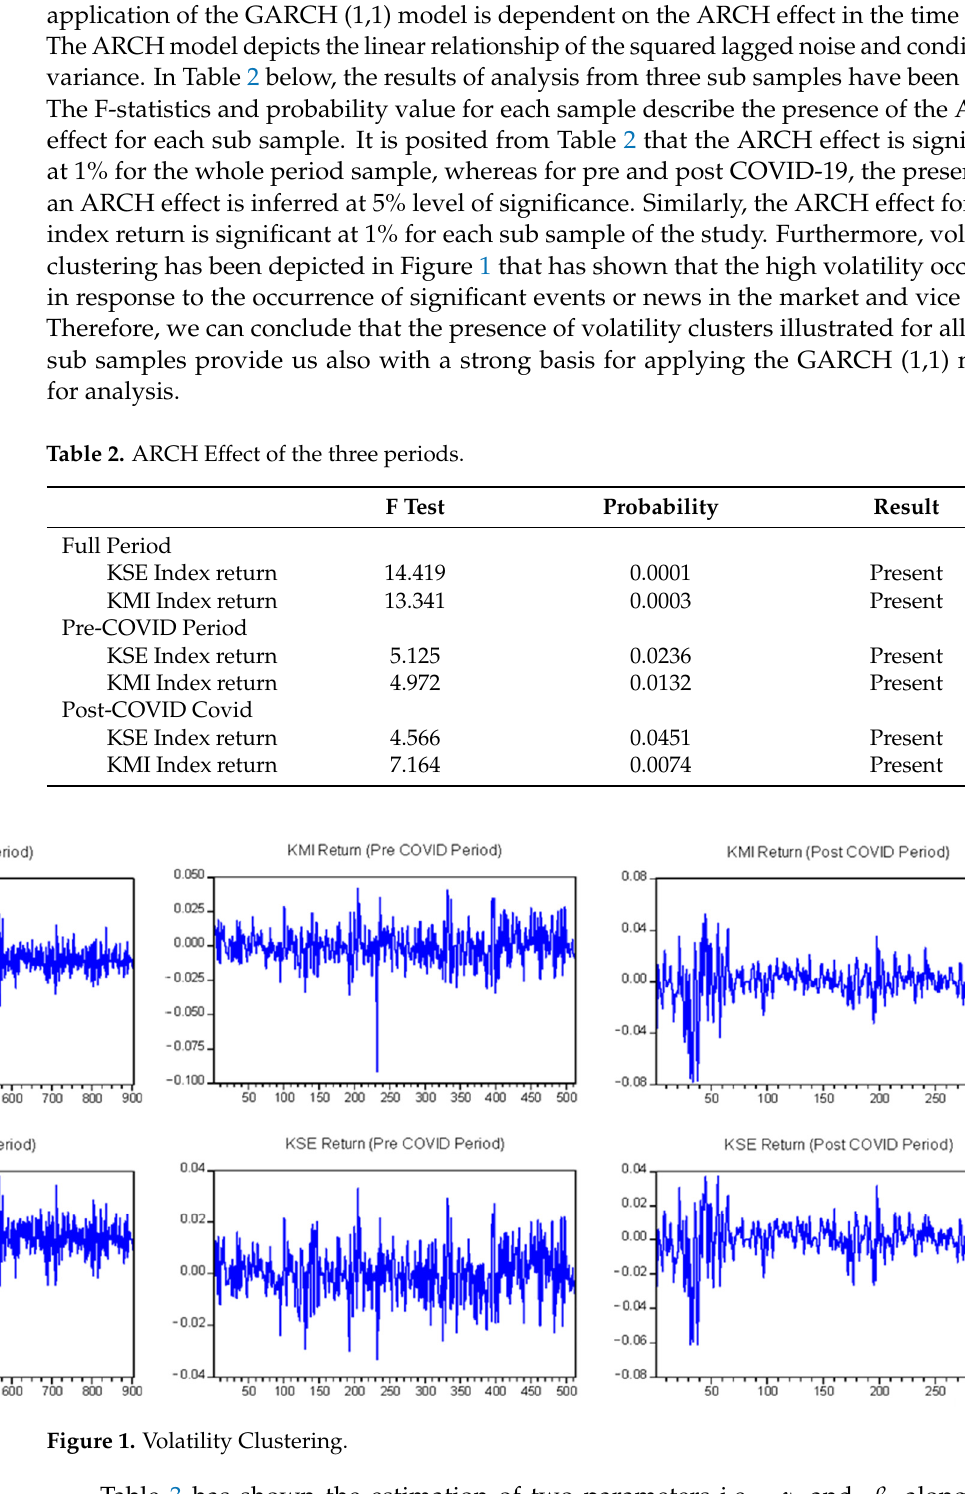
Table 3. GARCH (1,1) results.